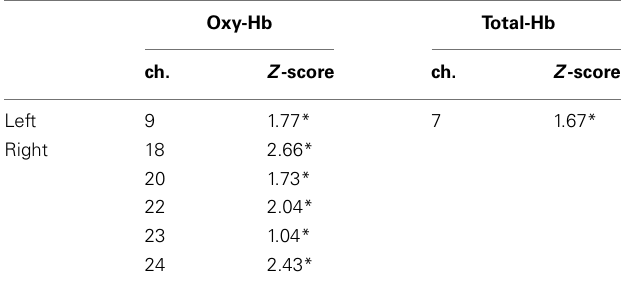
Table 2 | Channels activated in the different-face condition (Experiment 2) compared to the baseline on 7- to 8-month-old infants.